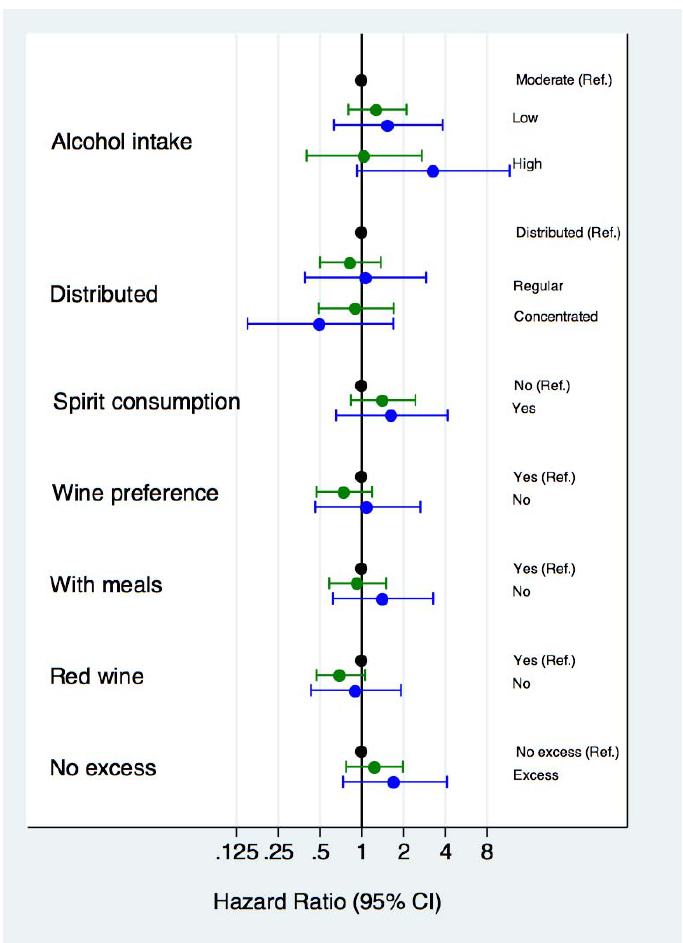
Figure 2. Cardiovascular disease (green) and cardiovascular mortality (blue) hazard ratios (HR) and 95% confidence intervals for each component of the Mediterranean alcohol ‐ drinking pattern.